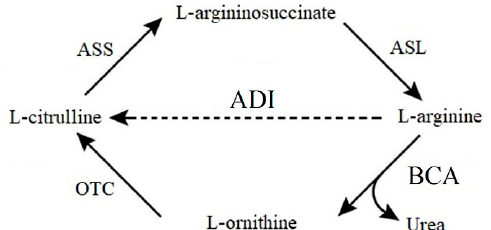
Figure 1. Urea cycle. Absence of ornithine transcarbamylase (OTC) or argininosuccinate synthetase (ASS) renders the cell incapable of synthesizing L-arginine from L-ornithine or L-citrulline, resulting in sensitivity to Bacillus caldovelox arginase (BCA) treatment. OTC-negative but ASS-positive cancer cells are resistant to arginine deiminase (ADI) treatment by recycling citrulline to arginine for survival. ASL: Argininosuccinate lyase.